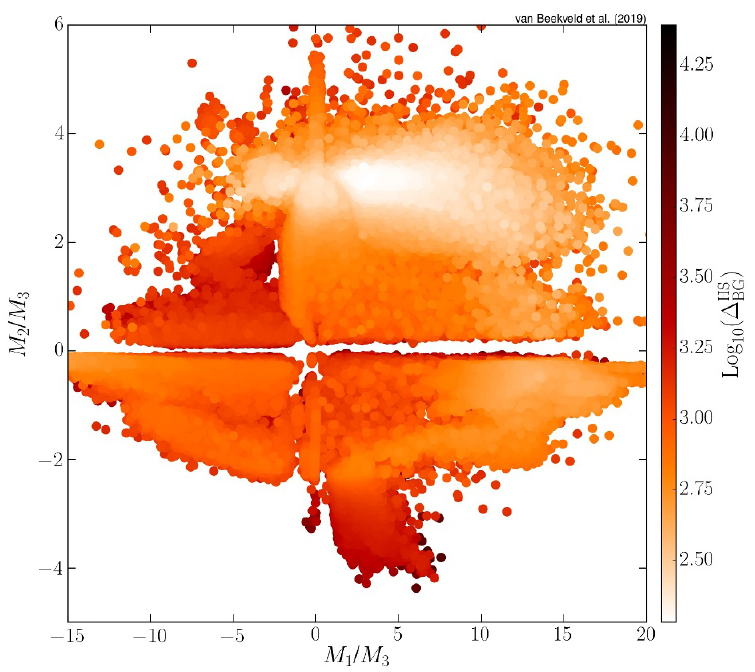
Figure 5 . Ratios of M 1 =M 3 and M 2 =M 3 for the allowed mSUGRA-var spectra. The color code indicates the value for log with higher values.